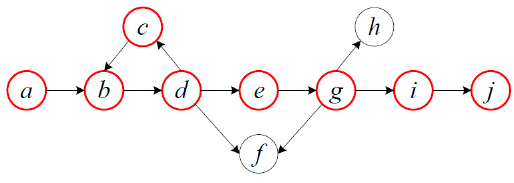
Figure 1. A sample directed graph, G.